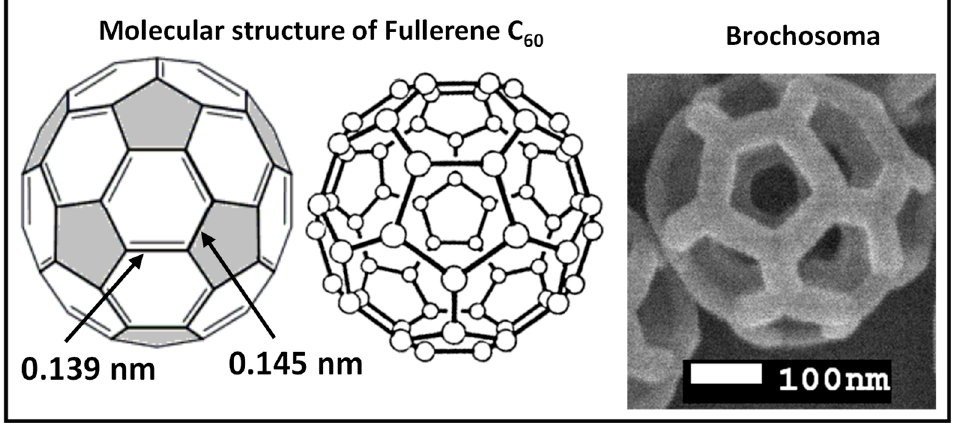
Figure 5. Comparison of brochosome shape with the molecular structure of fullerene C 60 [59,60].